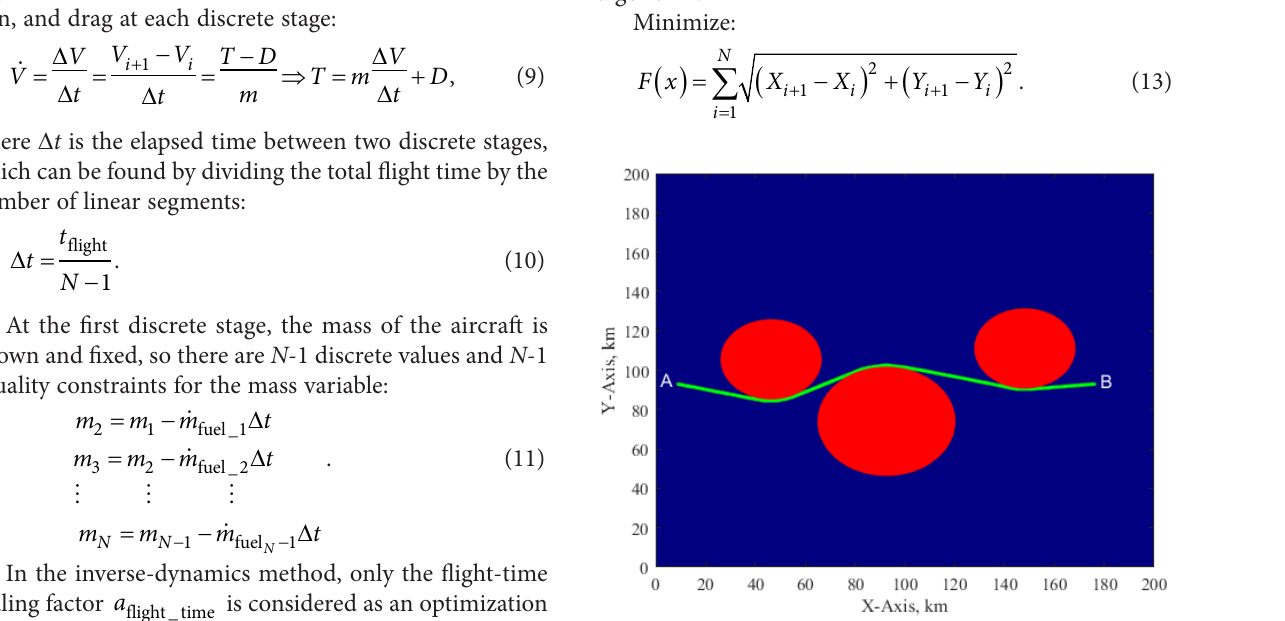
Figure 2. Shortest path for a sample obstacle-avoidance simulation environment without regard for flight